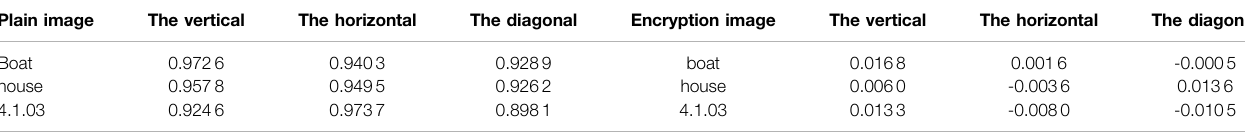
TABLE 4 | Correlation coef fi cients of different images before and after encryption Plain image The vertical